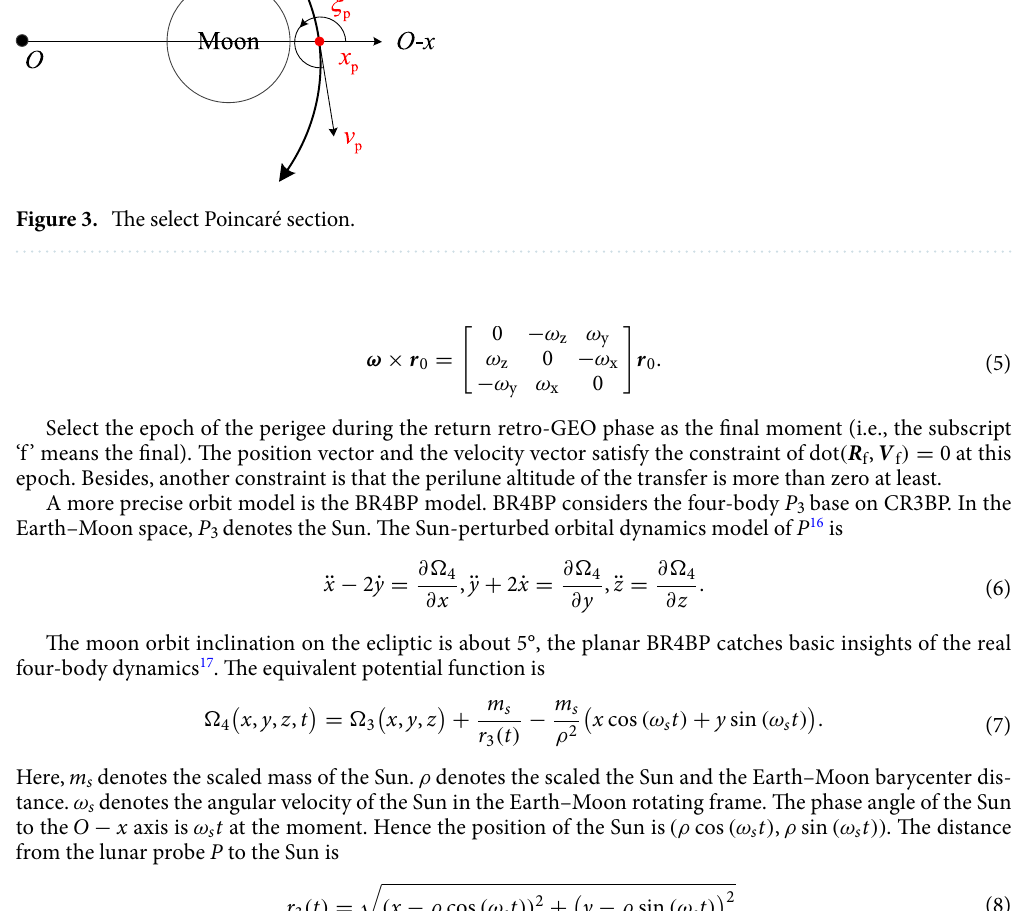
Figure 3. The select Poincaré